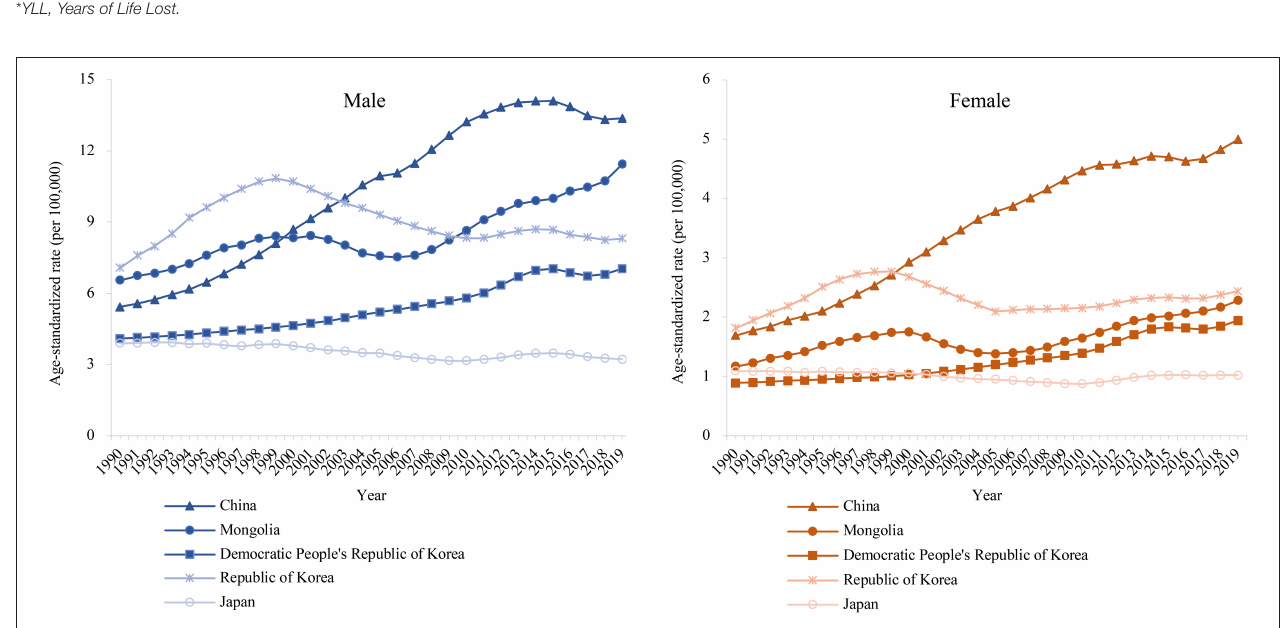
FIGURE 1 | The age-standardized rates of lung cancer attributable death to PM 2.5 in East Asia for both sexes at all ages, during